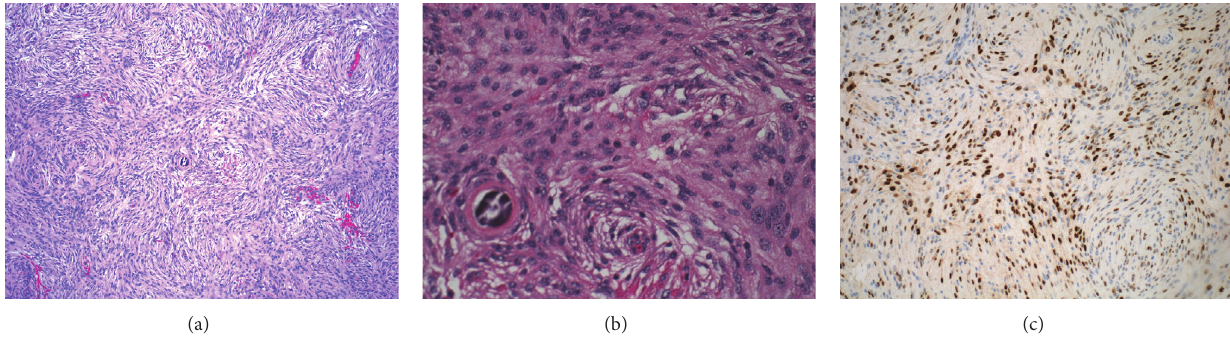
Figure 2: Histology of the tumor: (a) low magnification ( × 100) showing typical features of meningioma; (b) high magnification ( × 400) showing some evidence of nuclear atypia; (c) immunohistochemical staining showing the tumor to be progesterone receptor positive ( × 200